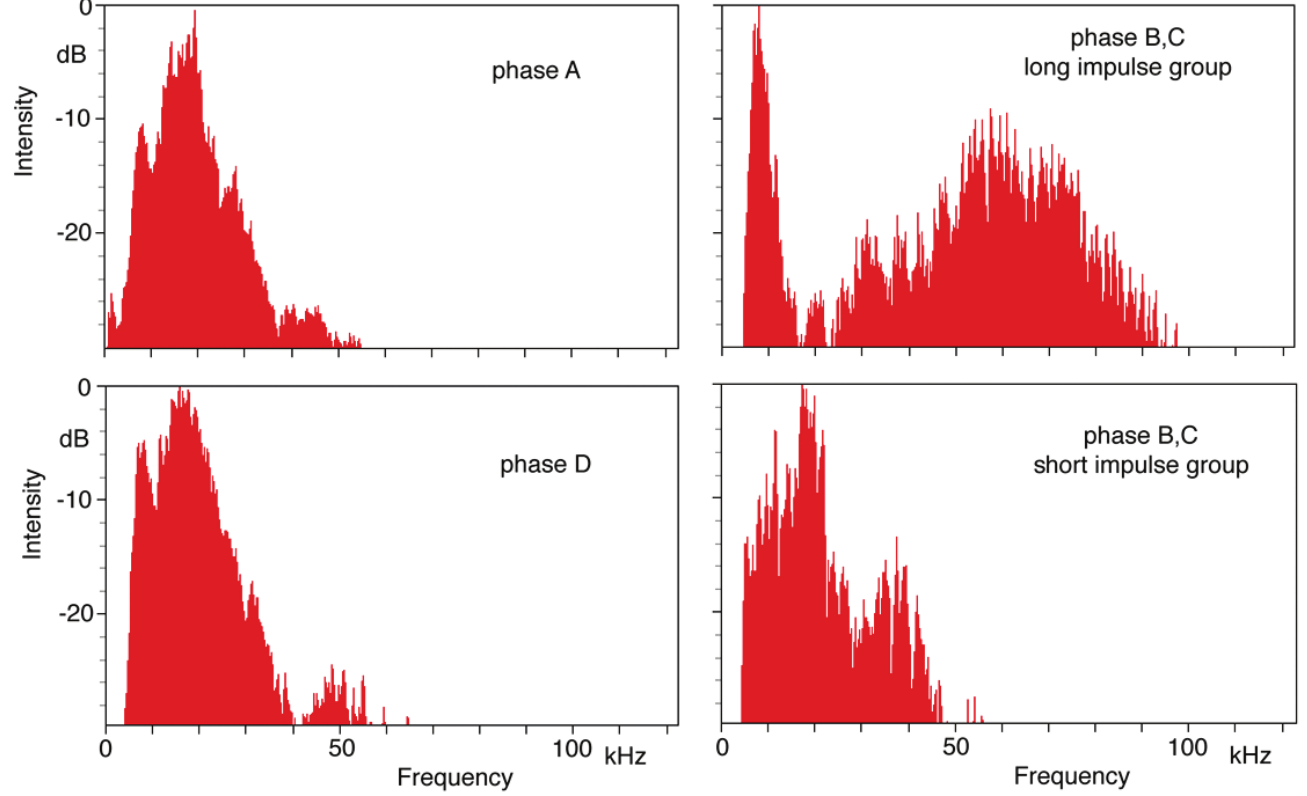
Figure 13. Power spectra of different parts of the calling song of E. diuturna sp. n.